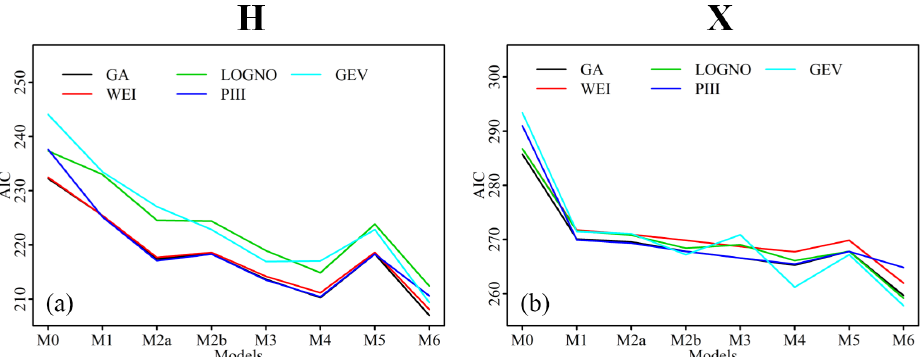
Figure 9. Comparisons of performance of stationary model (M0), time covariate model (M1) and physical covariate models (M2a, M2b, M3, M4, M5 and M6 with their corresponding optimal explanatory variables) for AM 30 in Huaxian (H) at (a) and Xianyang (X) at (b)